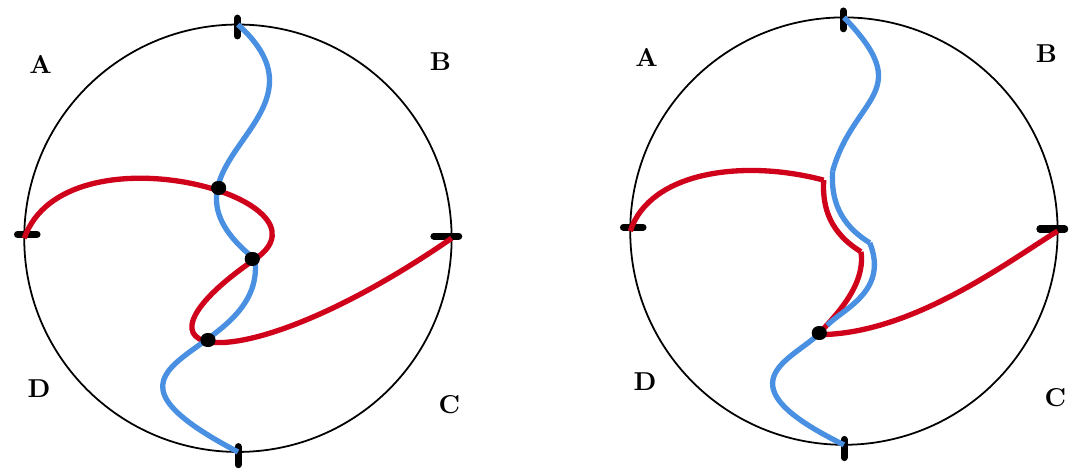
Figure 18 . Ensuring that two geodesics cross at most once. In the left figure, the red and blue curve cross each other multiple times. However, between each crossing, we can pick whichever curve has smaller length between the crossings, and use that for both curves, offsetting them by a slight amount to prevent intersection. This process can be continued until at most one crossing